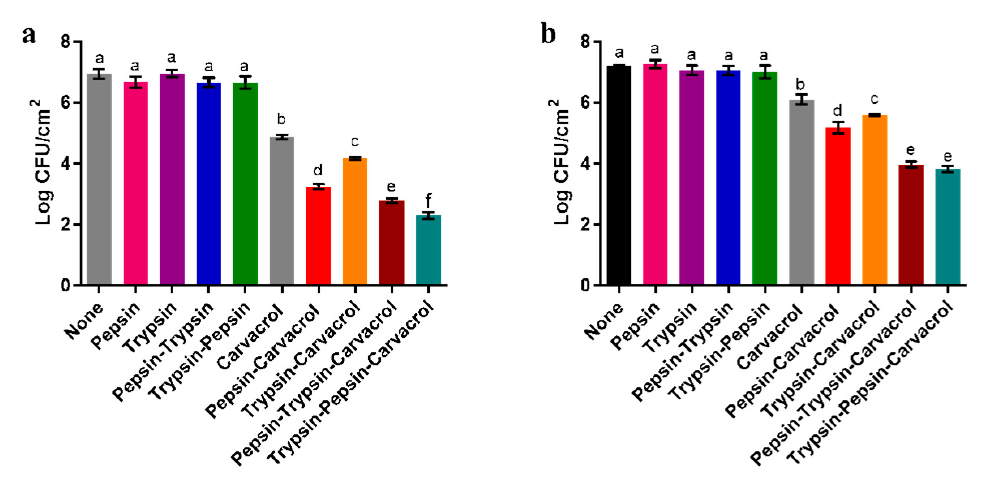
Figure 5. The reduction (in log CFU mL − 1 ) of P. aeruginosa ( a ) and E. faecalis ( b ) biofilms after treatment with pepsin, trypsin, or sequential treatment of both at a concentration of 1 mg mL − 1 for 1 h each, or followed by treatment with carvacrol at 1 / 2 MICs of each strain for 1 min for P. aeruginosa and 5 min for E. faecalis . Biofilms were developed on a stainless steel surface at 37 ◦ C for 24 h. Results are presented as the means ( ± SD) of three independent experiments. Different letters (a–f) indicate significant differences ( p < 0.05) using Tukey’s test.